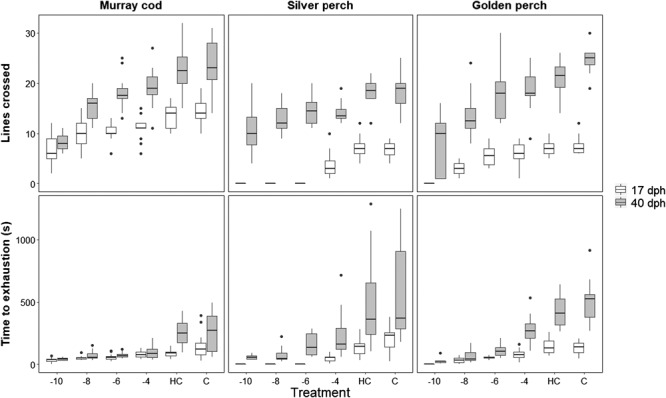
Assessment of lines crossed (within 30 s) and time to exhaustion (s) of Murray cod, silver perch and golden perch after exposure to cold shock treatments (−10, −8, −6, −4°C) from an initial temperature of 23°C. Assessment commenced 2 min after exposure to the cold shock treatments. A handled control (HC) and control (C) were used to determine effect of handling. Two age groups are assessed; old (40 ± 3 dph) and young (17 ± 1 dph)